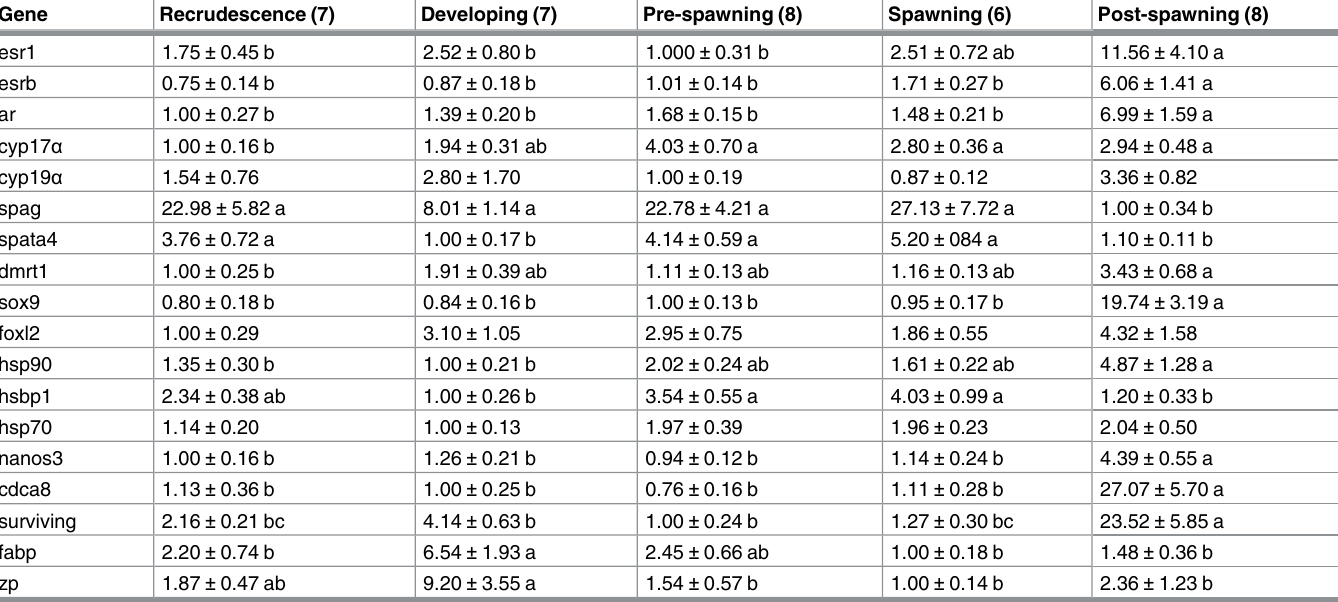
Table 4. Normalized fold change levels ± standard error for esr1 , esrb , ar , cyp17 α , cyp19 α , spag , spata4 , dmrt1 , sox9 , foxl2 , hps90 , hsp1 , hsp70 , nanos3 , cdca8 , surviving , fabp , and zp analyzed using real-time PCR in male gonads over the different stages of testis development. Differences amongtreatment groups(p < 0.01) for each gene are denotedwith different letters; outliers were includedin the